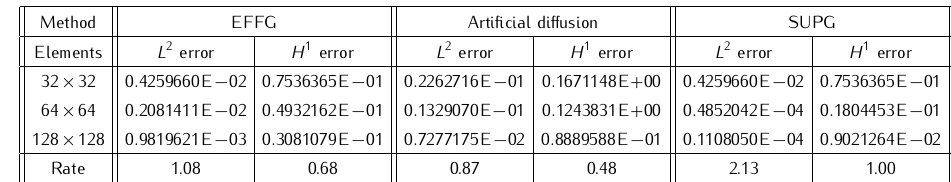
Table 4. Comparison of the L 2 -norm and H 1 -seminorm convergence rates of the exponentially fitted flux (EFF) method (18), the classical artificial diffusion, and the SUPG method, for ε = 0 . 001 and the velocity field from Example 3.